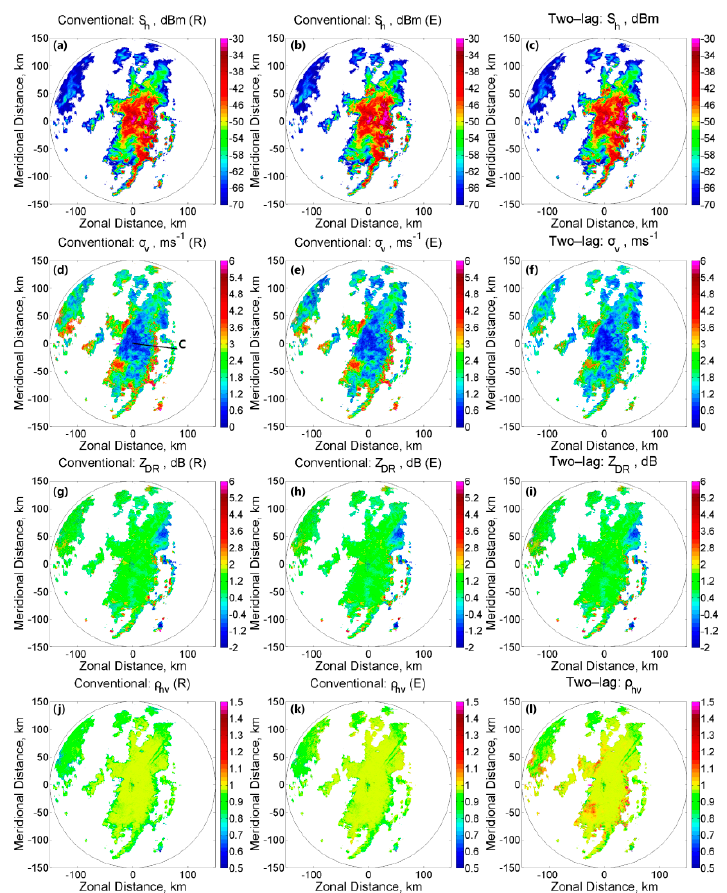
Figure 6. Comparison of conventional estimators (left and middle column) and two-lag estimators (right column). Four rows show S h , σ v , Z DR, and ρ hv , respectively. Letter R in brackets means that record noise power is used and letter E means that expert noise power is used. ( a ) S h (conventional, record noise power); ( b ) S h (conventional, expert noise power); ( c ) S h (two-lag); ( d ) σ v (conventional, record noise power); ( e ) σ v (conventional, expert noise power); ( f ) σ v (two-lag); ( g ) Z DR (conventional, record noise power); ( h ) Z DR (conventional, expert noise power); ( i ) Z DR (two-lag); ( j ) ρ hv (conventional, record noise power); ( k ) ρ hv (conventional, expert noise power); and ( l ) ρ hv (two-lag). Data are